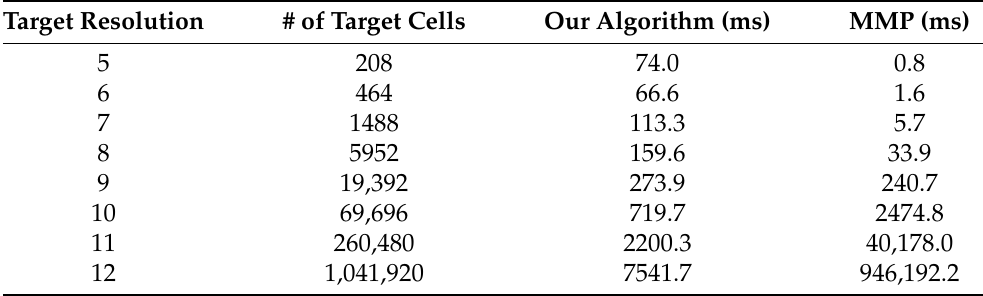
Figure 20. Execution time of our algorithm and the MMP algorithm at different resolutions for border of Ontario. Table 3. Execution time of our algorithm and MMP algorithm along with number of target cells for the border of